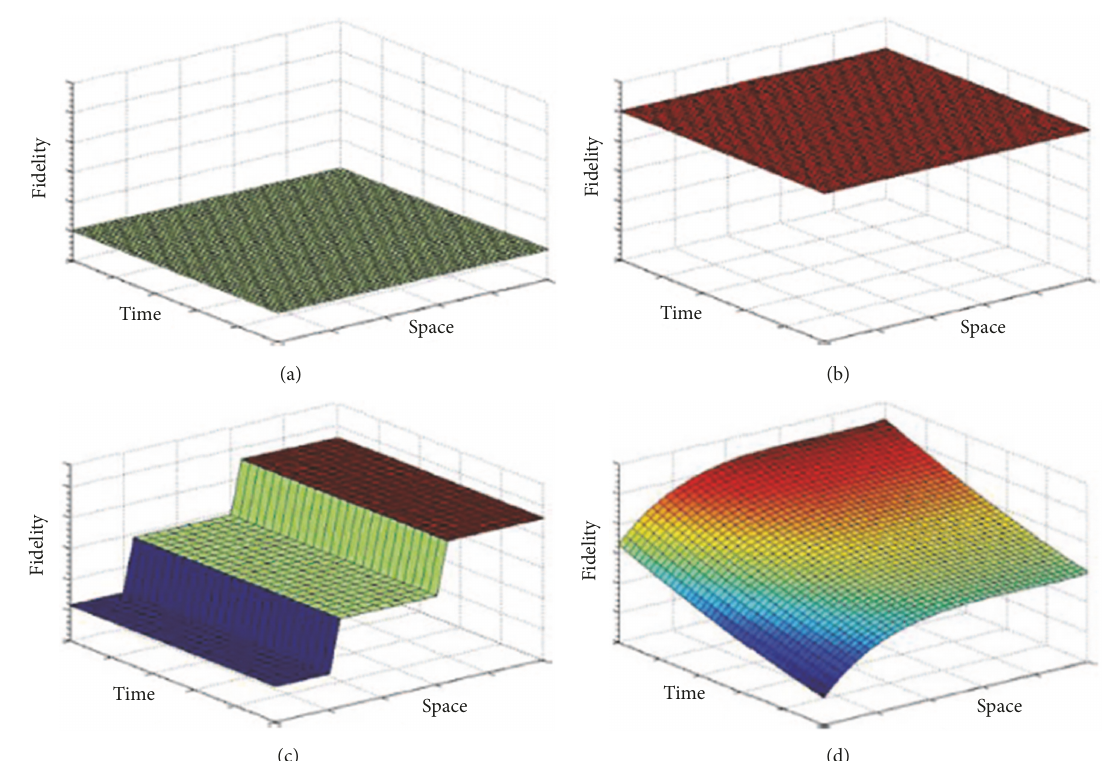
Figure3:Conceptualizationofsimulationsinspatial–temporalfidelitydomains:(a)mesoscopic,(b)microscopic,(c)hybrid,and(d)adaptive